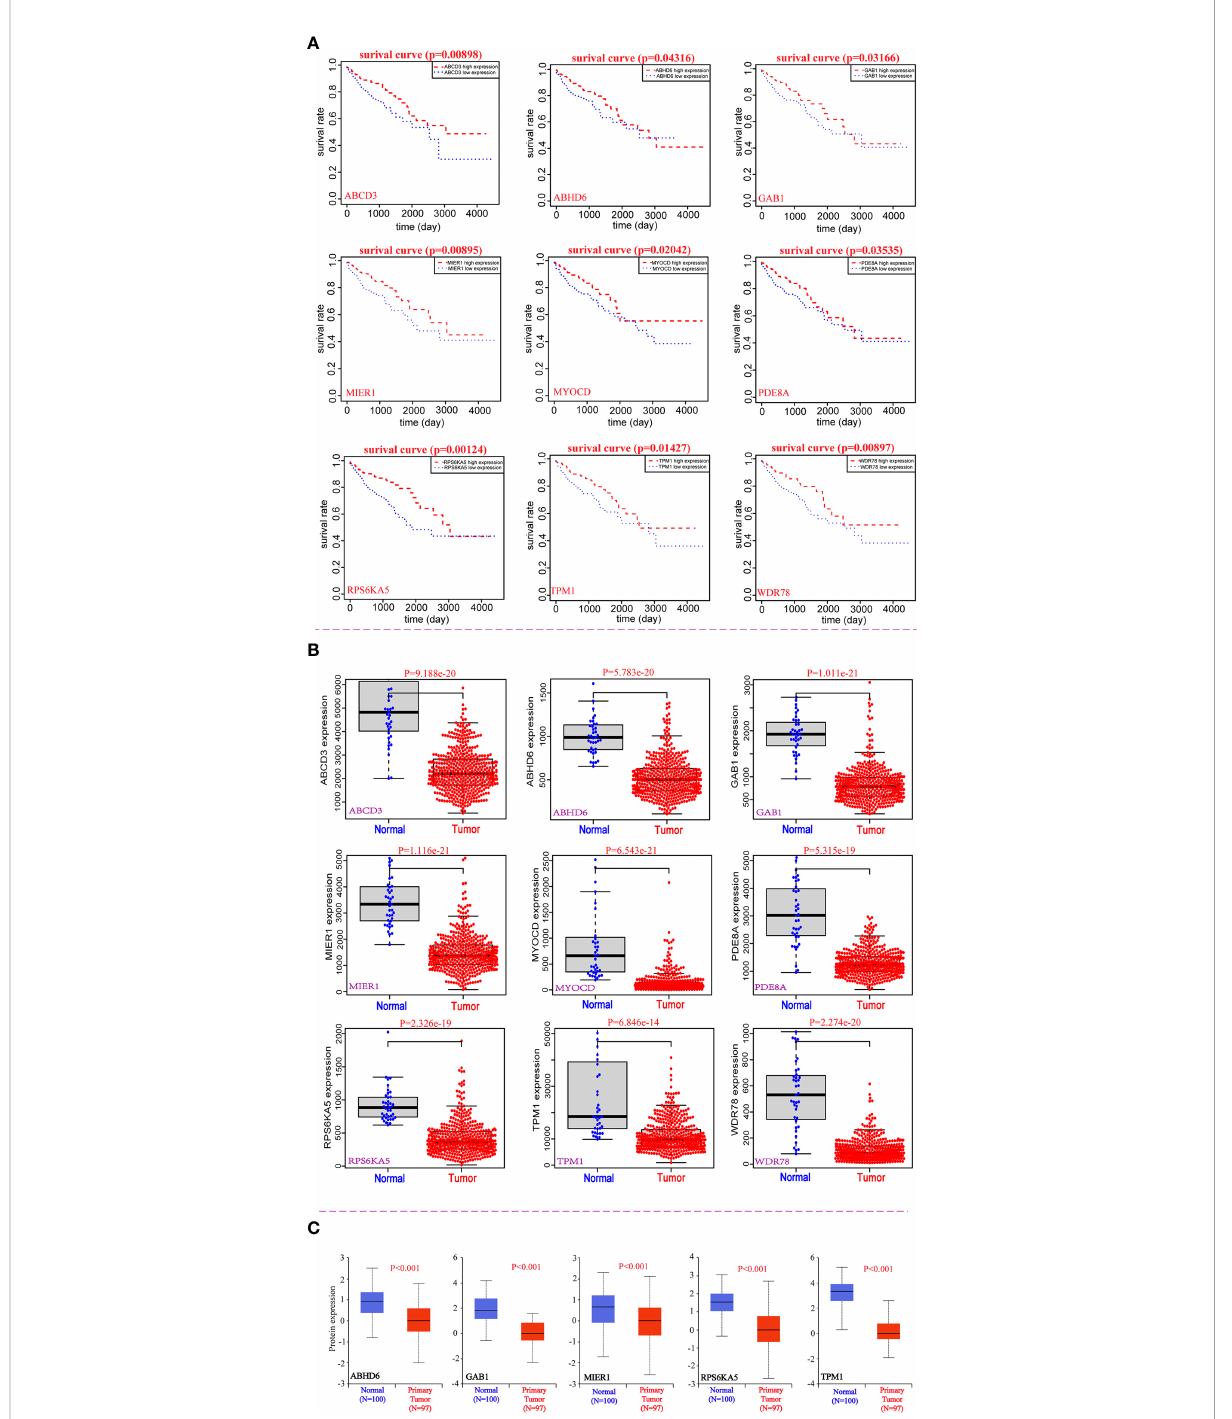
FIGURE 2 Correlation analysis between nine potential genes and the prognosis of CRC. (A) The prognostic value of nine potential genes in CRC. (B) The expression of nine potential genes at mRNA levels. (C) The expression of fi ve potential genes at protein